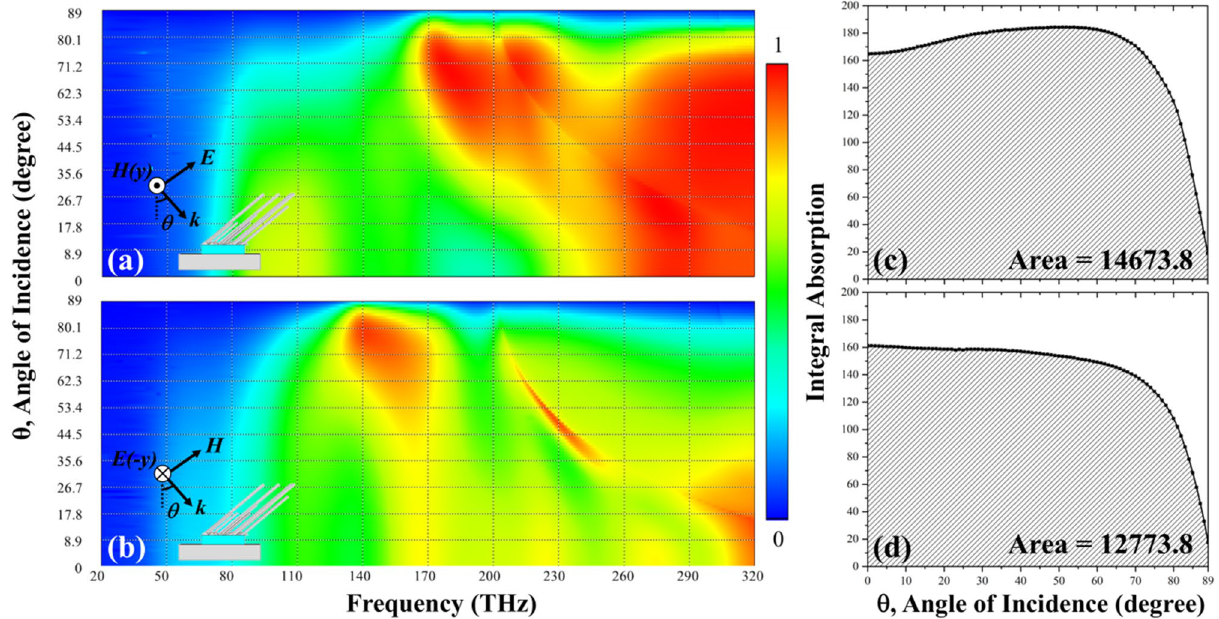
Figure 6. Absorbance diagram with respect to frequency and incident angles of SOFS MPAs for ( a ) TM and ( b ) TE modes. The integral absorbance plots with respect to the incident angle of SOFS MPAs for ( c ) TM and ( d ) TE modes. The integral areas of SOFS MPA are 14,673.8 and 12,773.8 for the TM and TE modes, respectively.